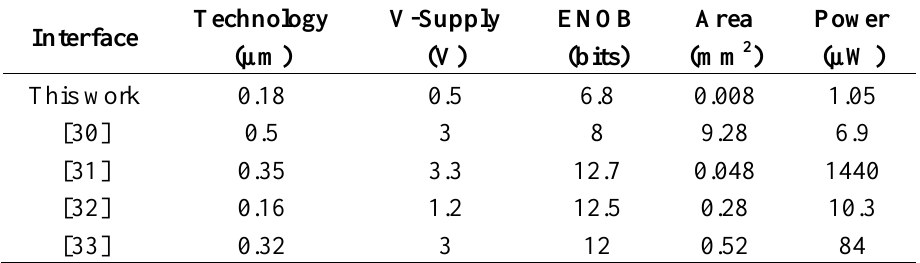
Table 1. Performance Comparison of Integrated Sensor